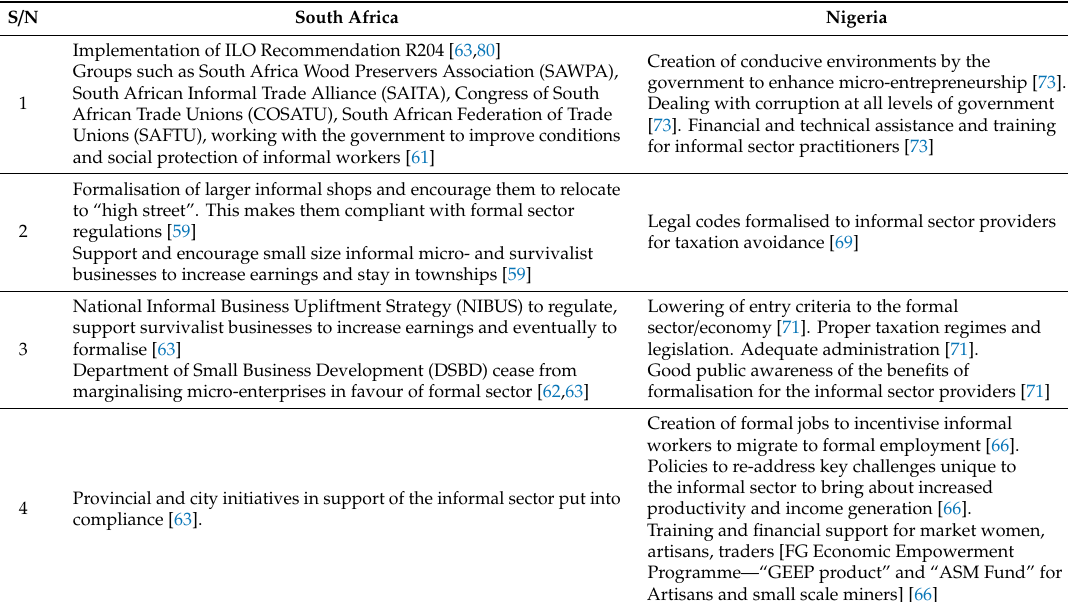
Table 13. Policy incentives from the governments of South Africa and